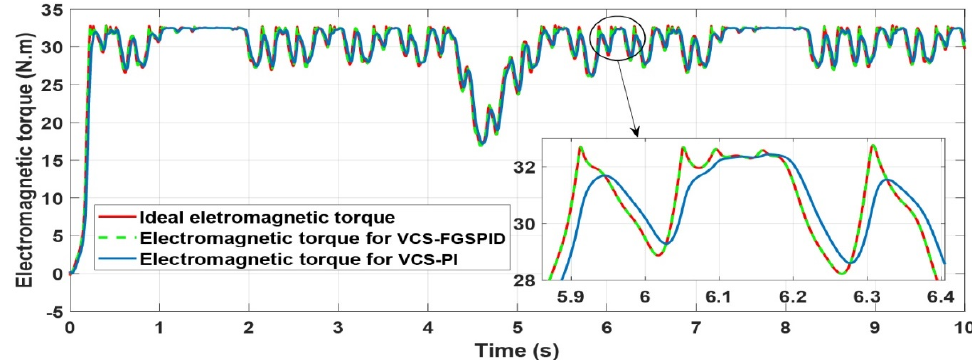
Figure 23. Electromagnetic torque.